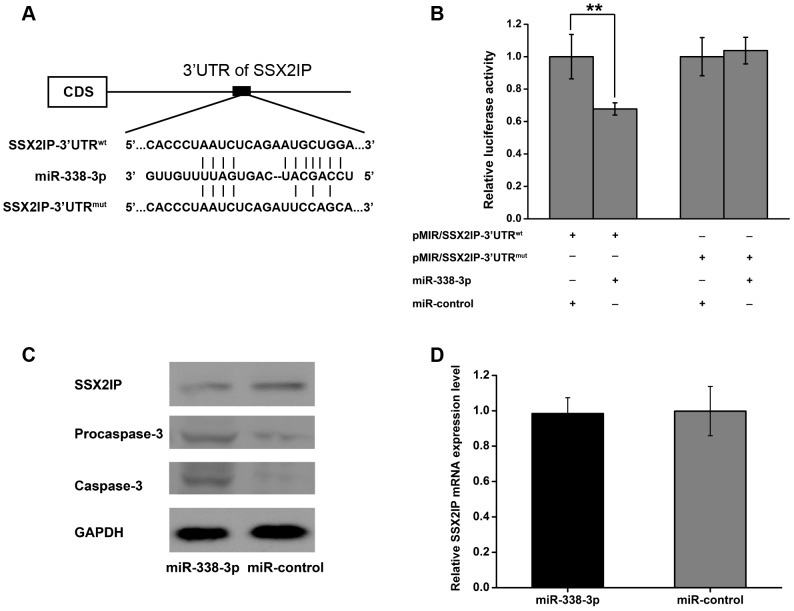
miR-338-3p targets 3′UTR of SSX2IP and induces Caspase-3 expression.(A) Schematic graph of the putative binding sites of miR-338-3p targeted the 3′UTR of SSX2IP. (B) miR-338-3p mimics downregulated luciferase activities controlled by wild-type 3′UTR of SSX2IP(**P<0.01), but did not affect luciferase activity controlled by mutant 3′UTR of SSX2IP. The results are means of three independent experiments ± S.D. (C) SSX2IP, Caspase-3 and Pro-casepase-3 were detected by Western blot at 48 h post-transfection with miR-338-3p and control mimics. (D) SSX2IP mRNA in SGC-7901 cells analyzed by qPCR at 48 h post-transfection with miR-338-3p and control mimics.